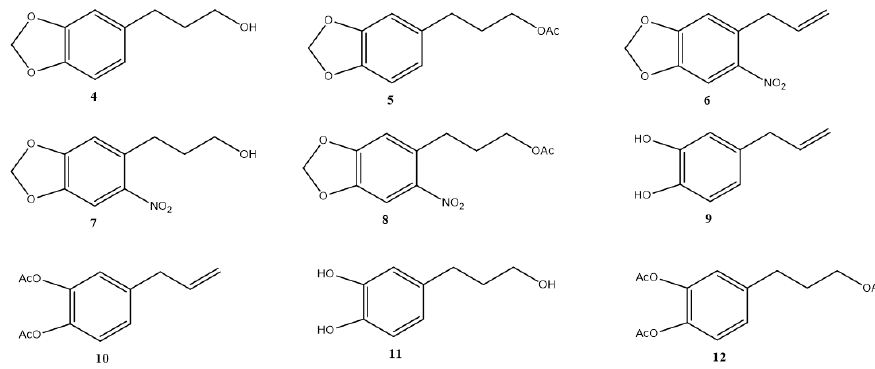
Figure 2. Structure of safrole derivatives 4 – 12 .